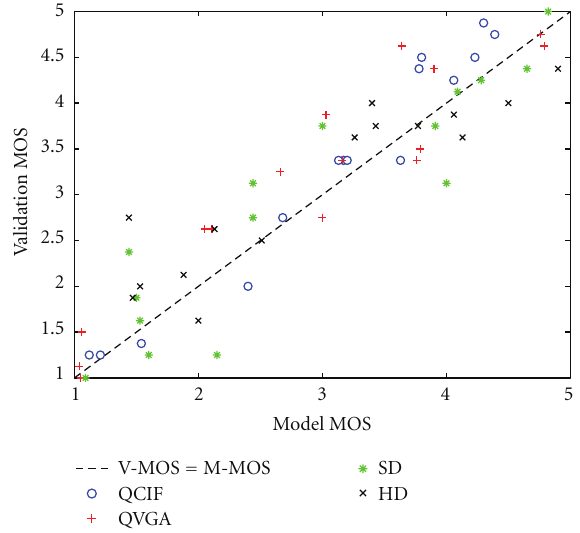
Figure 14: Correlation between PFIFO model MOS and PFIFO validation MOS.